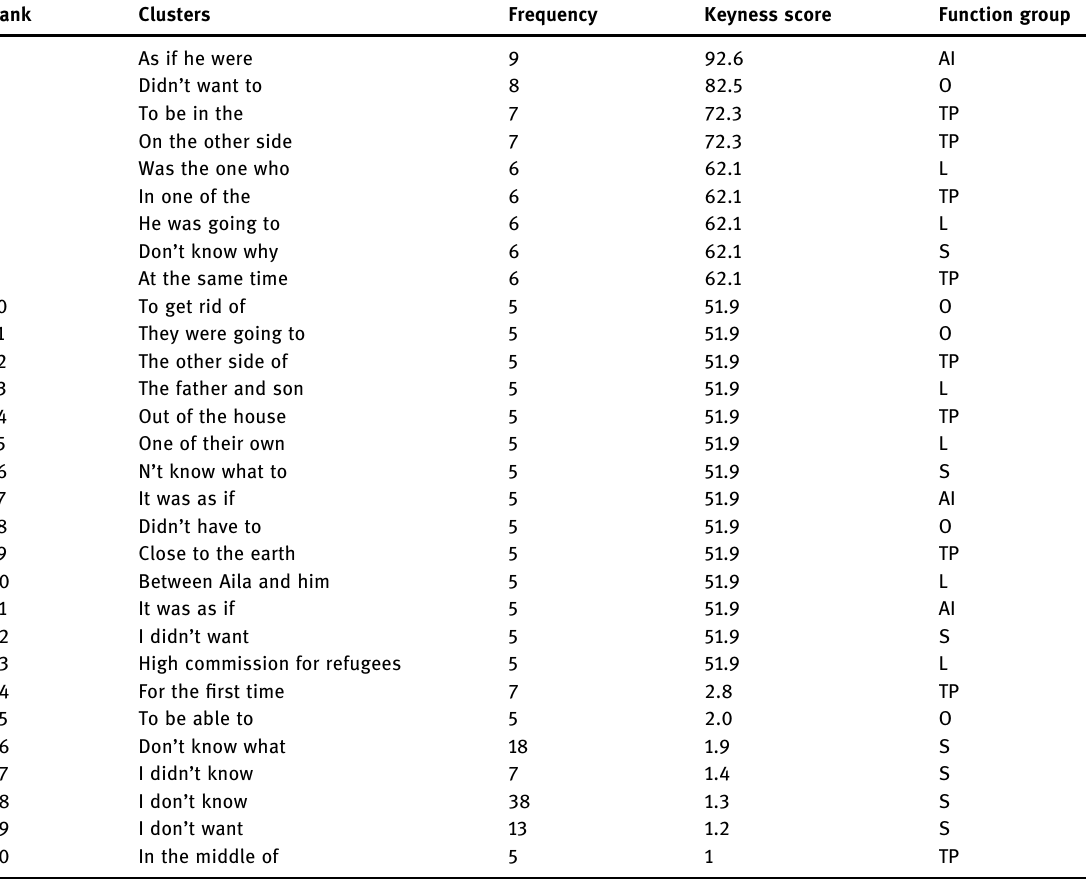
Table 4: Four - word clusters in